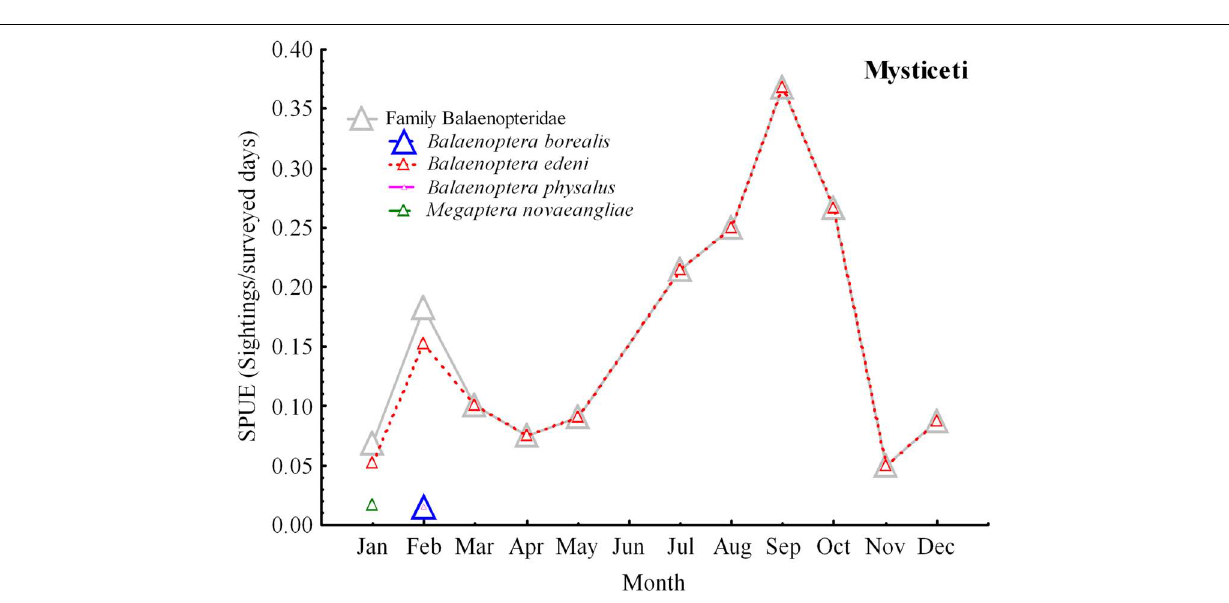
FIGURE 5 | Temporal variation of total cetacean sightings per unit effort (SPUE; sighting/surveyed days) in the Canary Islands during the study period (Jan. 2007–Dec. 2018). Gray triangle: Family Balaenopteridae; blue triangle: Balaenoptera borealis ; red triangle: Balaenoptera edeni ; pink triangle: Balaenoptera physalus ; green triangle: Megaptera novaeangliae